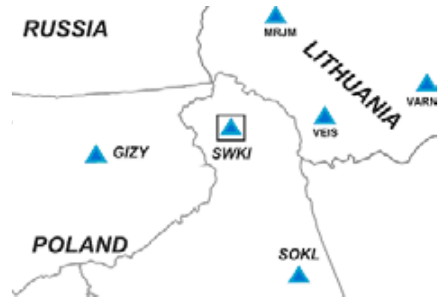
Fig. 14. GNSS stations at Poland-Lithuania border